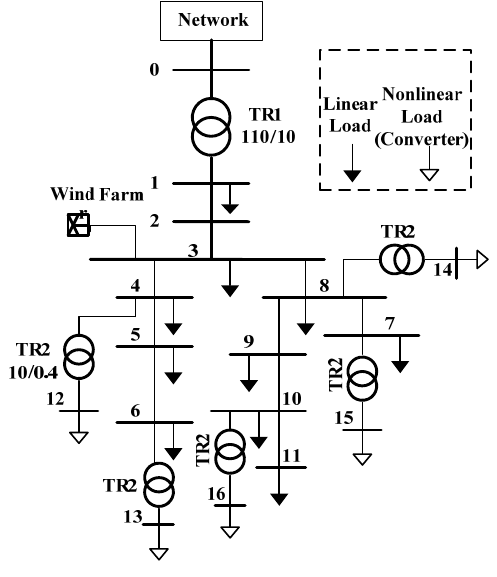
Figure 7. The simulation network with the small-scale wind farm and nonlinear loads.